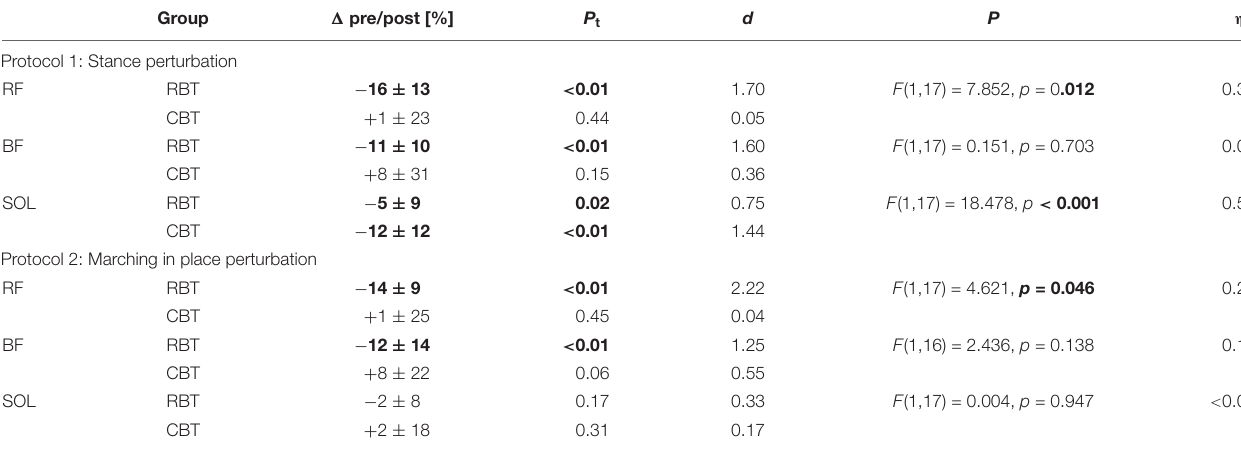
TABLE 2 | Onset latency of the electromyograms during stance and marching in place perturbation.